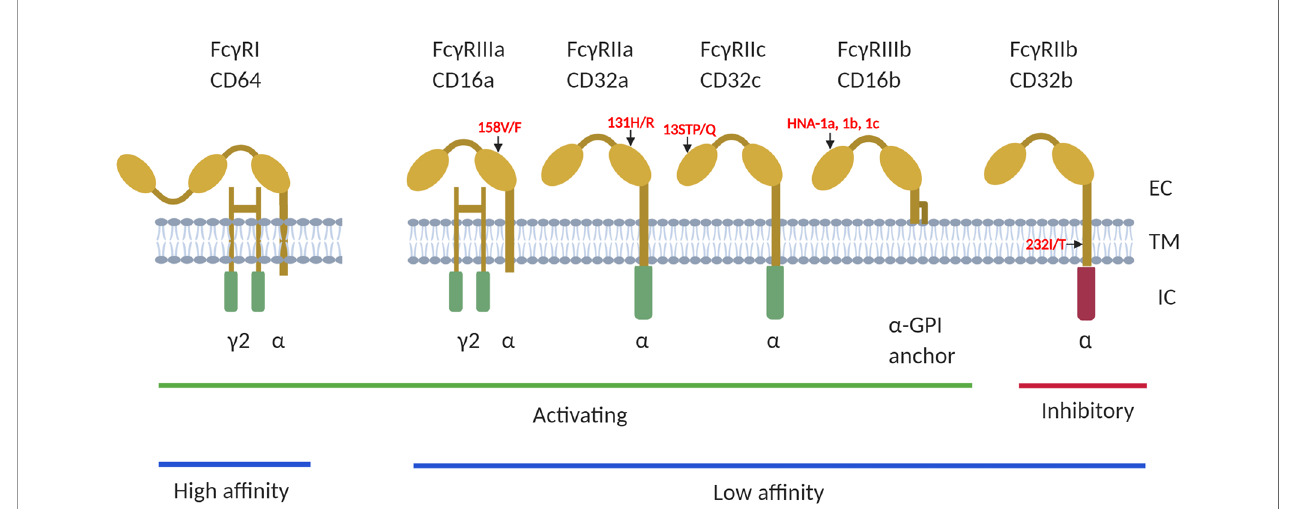
FIGURE 1 | The human FCGRs consists of 3 classes; Fc g RI (CD64), Fc g RII (CD32) and Fc g RIII (CD16), of which Fc g RI has high af fi nity to bind to antibody Fc- fragment. Fc g RII and Fc g RIII have low af fi nity for IgG binding. They are also classi fi ed as activating or inhibitory due to the signals induced by FcR crosslinking. The Fc g RI, Fc g RIIa/IIc and Fc g RIIIa and Fc g RIIIb proteins contain the immunoreceptor tyrosine based activating motifs (ITAM), whiles Fc g RIIb is the only receptor that contains the immunoreceptor tyrosine based inhibitory motif (ITIM), in its cytoplasmic domain. Additionally, the Fc g RIIIb gene encodes a glycosylphosphatidylinositol (GPI) -anchored receptor, and this encodes human neutrophil speci fi c antigen 1 (HNA1a, b and c). Several functional polymorphisms exist in the Fc g R genes, including the Fc g RIIa-131H/R of which the 131-H allele has a high binding af fi nity to IgG2 and Fc g RIIIa-176V/F with the 176-V allele being more effective at mediating phagocytosis. The Fc g RIIc gene encodes either a glutamine (Q) or a stop codon (STP) at position 13 while the 232-T allele of the Fc g RIIb 232I/T polymorphism has a reduced inhibitory signaling capacity. EC, extracellular domain; TM, transmembrane domain; IC, intracellular domain. Summaries of studies that have investigated different interactions between the receptors on different HIV infection outcomes have been provided in Tables 1 , 2